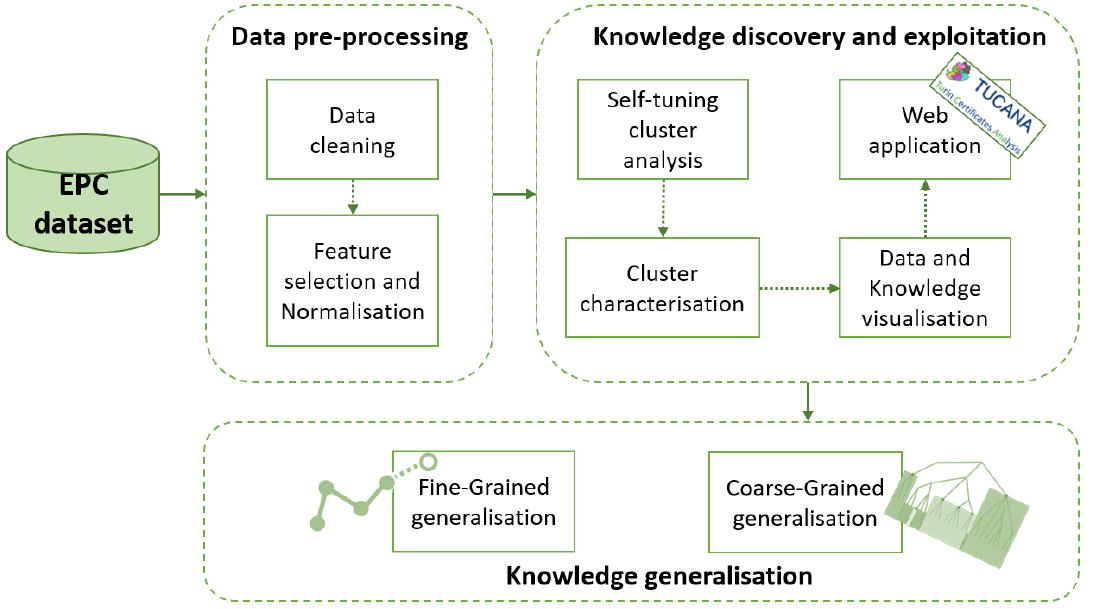
Figure 1. The TUCANA